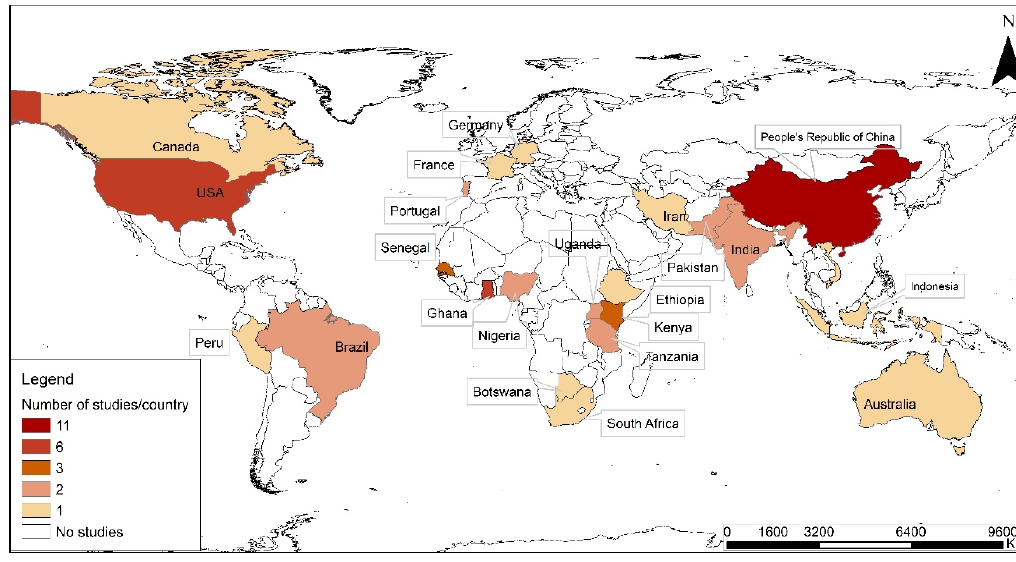
Figure 4. Distribution of reviewed studies by country/region (1995–2019).